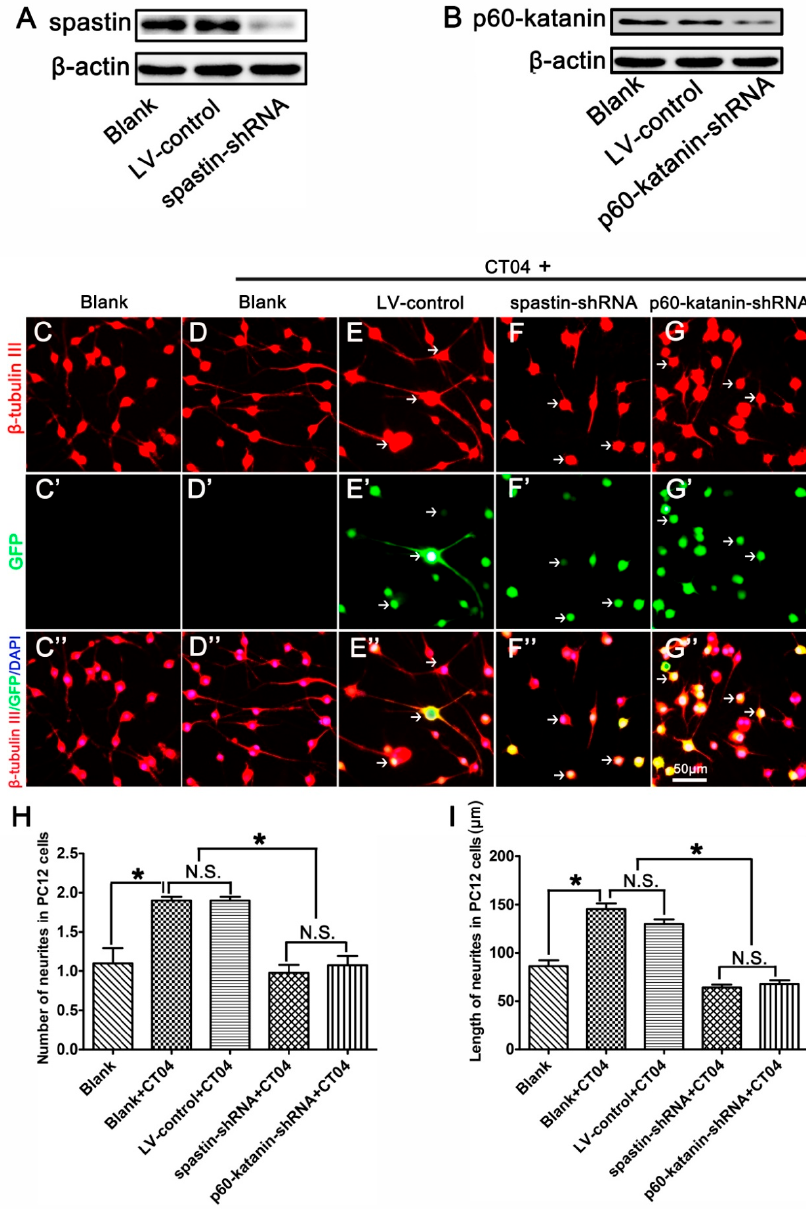
Figure 6. Lentiviral spastin-shRNA and p60-katanin-shRNA blocks the positive e ff ect of CT04 on neurite outgrowth. ( A ) Western blotting demonstrated that spastin-shRNA transfection reduced the expression of spastin compared with the LV-control and Blank groups in di ff erentiated PC12 cells. ( B ) Western blot detection showed that p60-katanin-shRNA transfection decreased the expression of p60-katanin compared with the LV-control and Blank groups. ( C – D , C (cid:48) – D (cid:48) , C” – D” ) The neuronally di ff erentiated PC12 cells were treated with CT04 for 24 h. Representative immunofluorescence staining for β -tubulin III revealed that CT04 treatment induced neurite outgrowth in neuronally di ff erentiated PC12 cells. ( E – G , E (cid:48) – G (cid:48) , E” – G” ) A lentiviral vector targeting spastin or p60-katanin (spastin-shRNA / p60-katanin-shRNA) and a control vector (LV-control) were employed to transfect di ff erentiated PC12 cells. After 5 days, the cells were treated with CT04 for 24 h. Quantitative analyses of the number ( H ) and length ( I ) of the neurites of each cell in di ff erent groups. The results revealed that, compared with the LV-control and Blank groups, spastin-shRNA or p60-katanin-shRNA transfection reversed the positive e ff ect of CT04 on neurite outgrowth. The blots were cropped from di ff erent parts of the same gel. The data are shown as the mean ± SEM values (* indicates p < 0.05, meaning a statistically significant di ff erence, while N.S. indicates